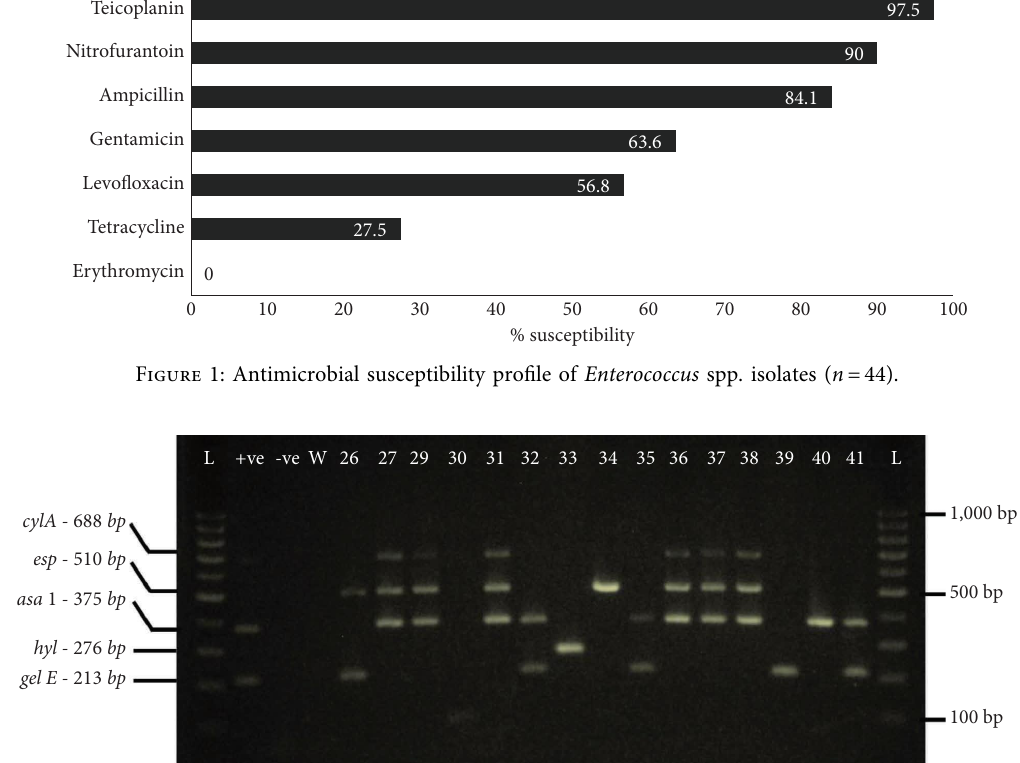
Figure 2: A representative gel electrophoresis image indicating the presence or absence of the fve virulence genes in some of the En- terococcus spp. isolates. L-100bp ladder; +ve-positive control E. faecalis ATCC 29212; − ve-negative control E. coli ATCC 25922; W- nuclease-free water; Lane numbers-individual isolates; bp-base pairs.